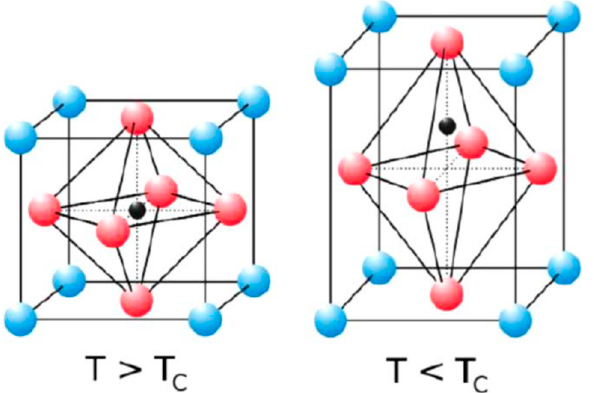
Figure 6. Structure of LaAlO 3 . La 3+ is the cation placed in the corners (at site A, blue ball). Al 3+ is the cation placed in the center (at site B, black ball) (Reprinted with permission from [29]).